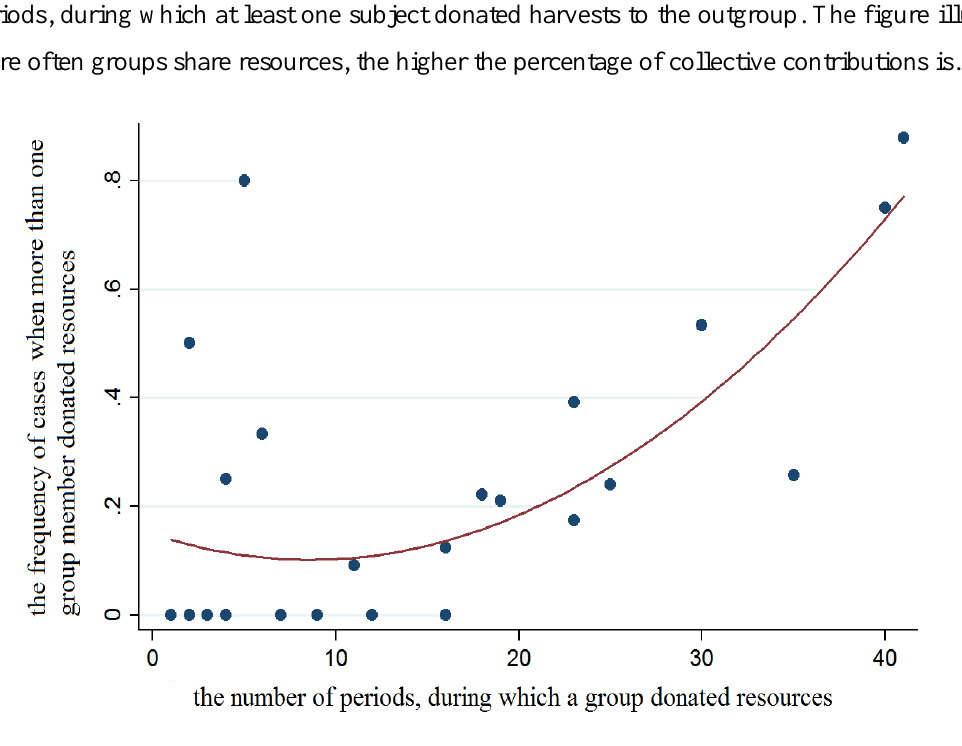
Figure A1.2 The frequency of intergroup sharing versus collective